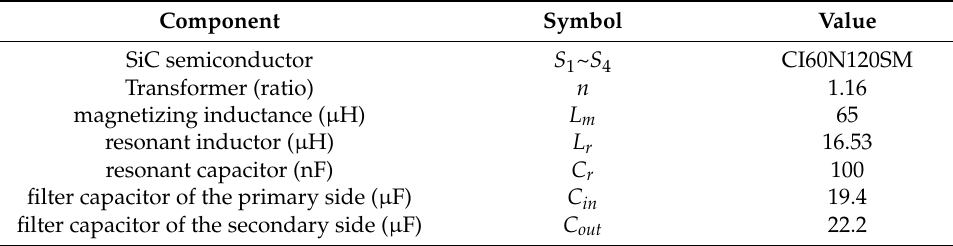
Table 2. Design parameters for